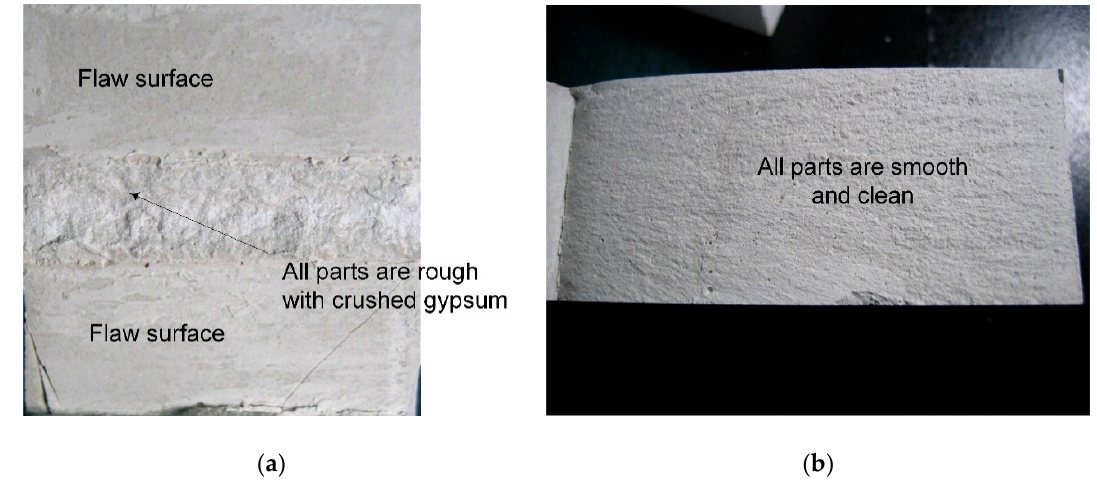
Figure 18. Comparison of the crack surface. ( a ) Surface of shear cracks. ( b ) Surface of wing cracks.